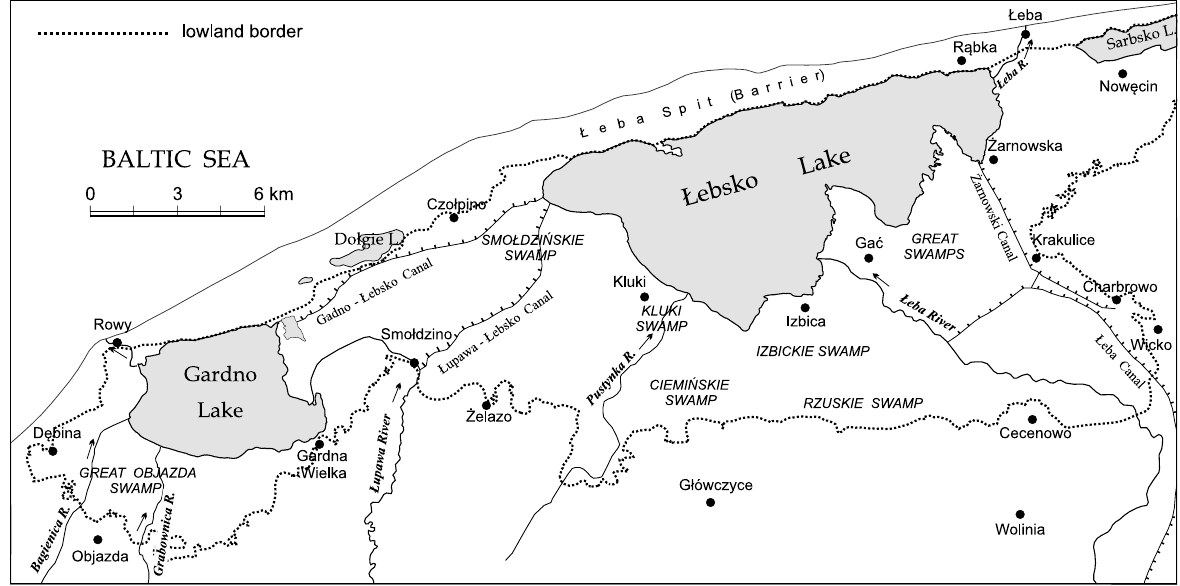
Fig. 1. The study